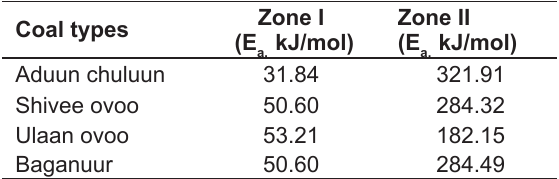
Table 3. Activation energies of Aduun chuluun, Shivee ovoo, Ulaan ovoo and Baganuur coals